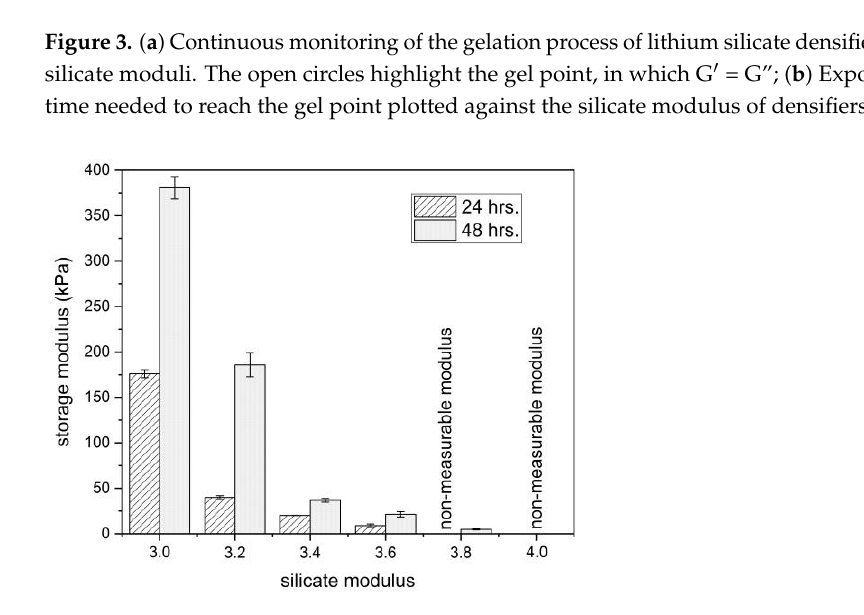
Figure 4. Values of the storage modulus of lithium silicate densifiers with different silicate moduli determined using discontinuous rheological experiments after 24 and 48 h.